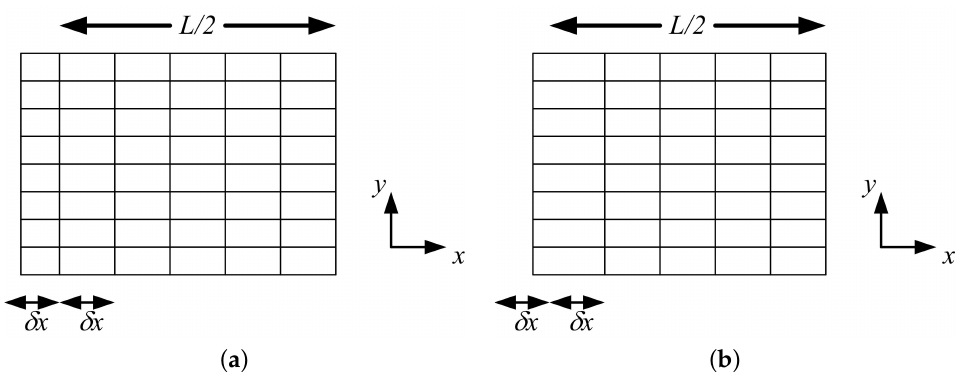
Figure A3. The process of layer removal during the mesh motion procedure: ( a ) shortly before the outermost layer is removed; ( b ) shortly after the outermost layer is removed. On the other hand, the alternative strategy—layer removal—compresses only the layer of the mesh closest to the plunger; the basic principle is illustrated in Figure A3. The width of this layer is reduced until a user-defined minimum layer thickness is reached; for illustrative purposes, we have taken it here to be δ x /2, where δ x is the initial mesh size in the x -direction. Figure A3a shows the situation just before this layer is removed. If the width of this last layer is about to decrease below the user-specified limit, the mesh motion solver removes that layer and adds its residual width to the next layer by adjusting the points of that layer, as shown in Figure A3b. In this paper, the strategy of layer removal was preferred over mesh compression, as it proved to be more stable. Also, a computational speed-up was observed towards the end of the simulation using the layer removal strategy, as the solver had fewer and fewer cells to handle during the later time